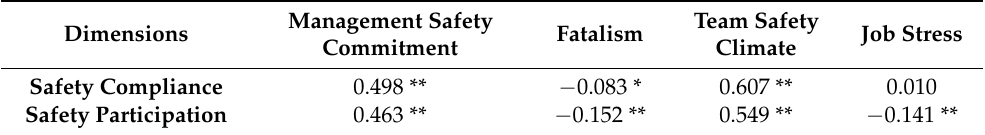
Table 7. Correlation coefficients between safety attitude and safety behaviors. Dimensions